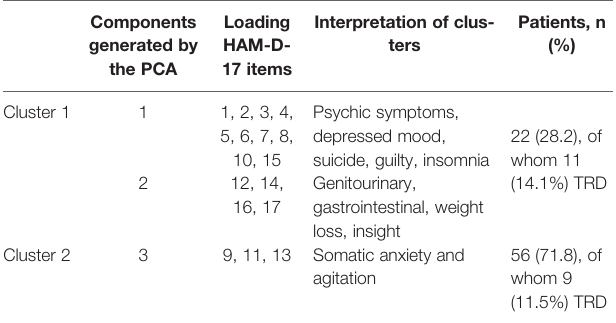
TABLE 4 | Clusters and their characterization generated by two-step cluster analysis based on the three components obtained upon principal component analysis (PCA) on MDD patients.